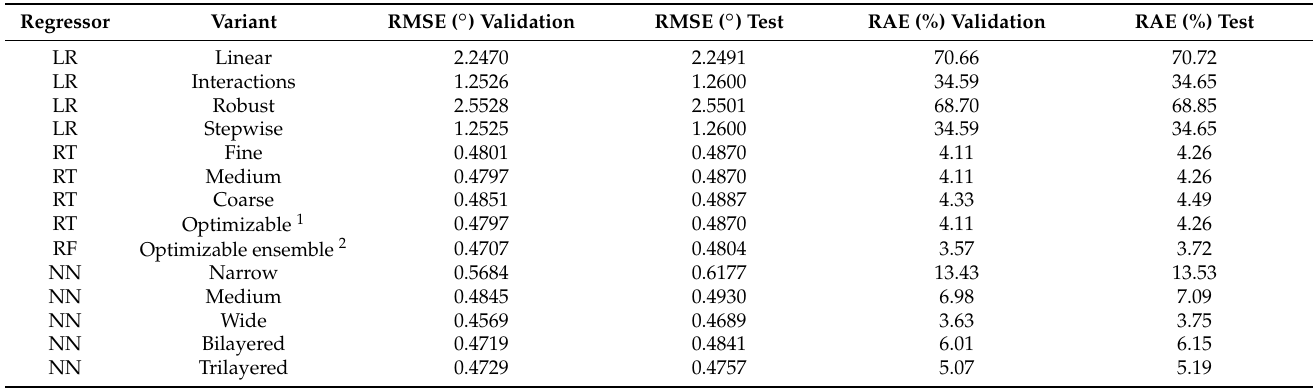
Table 1. Results of training the regressors without considering (cid:101) normal and the rotation axis between normals with holdout validation.